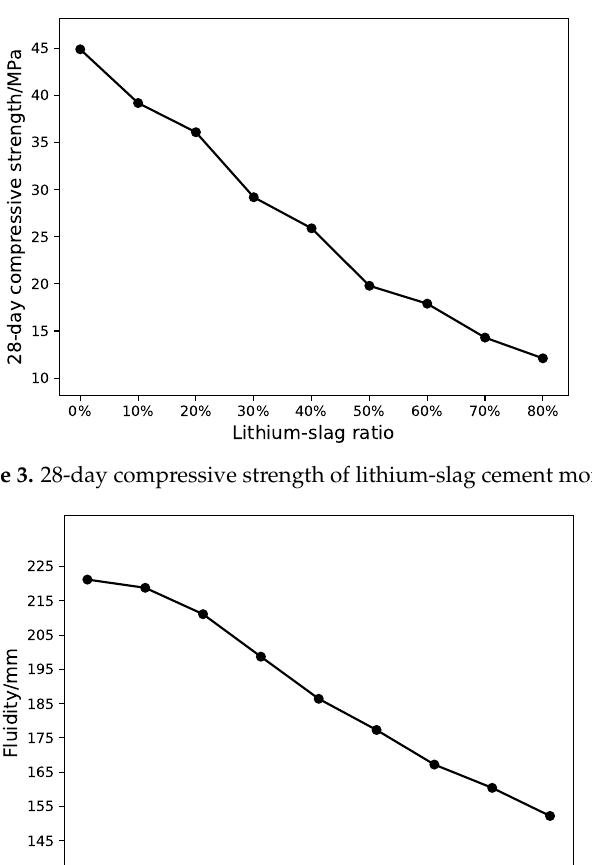
Figure 2. 7-day compressive strength of lithium-slag cement mortar.